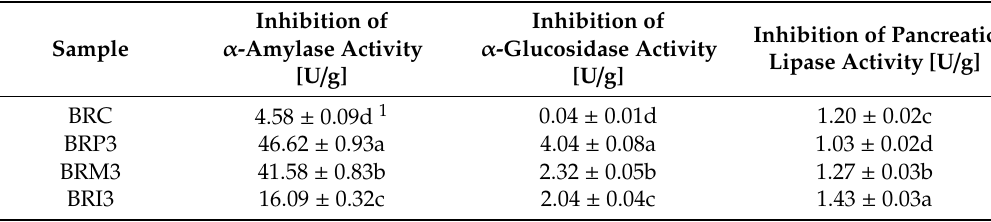
Table 6. Enzymatic in vitro inhibition activity of enriched rye bread.